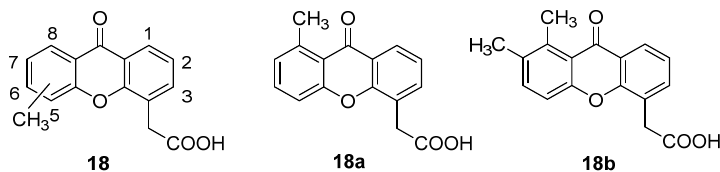
Figure 13. Methyl-substituted DMXAA analogues.